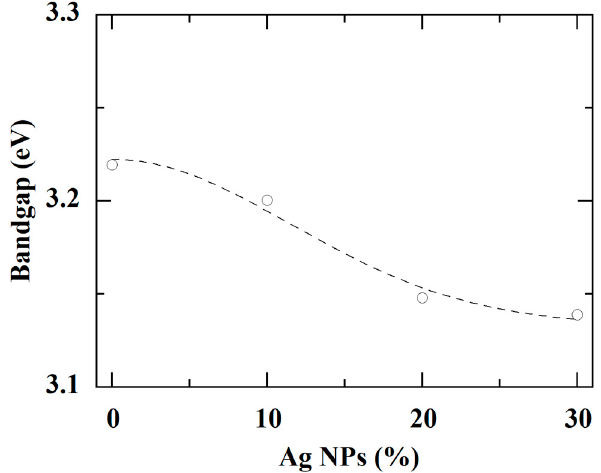
Figure 11. Bandgap of pure ZnO thin film and ZnO/Ag(NPs) nanocomposite thin films. The dashed curve is provided as a guide for the eye.